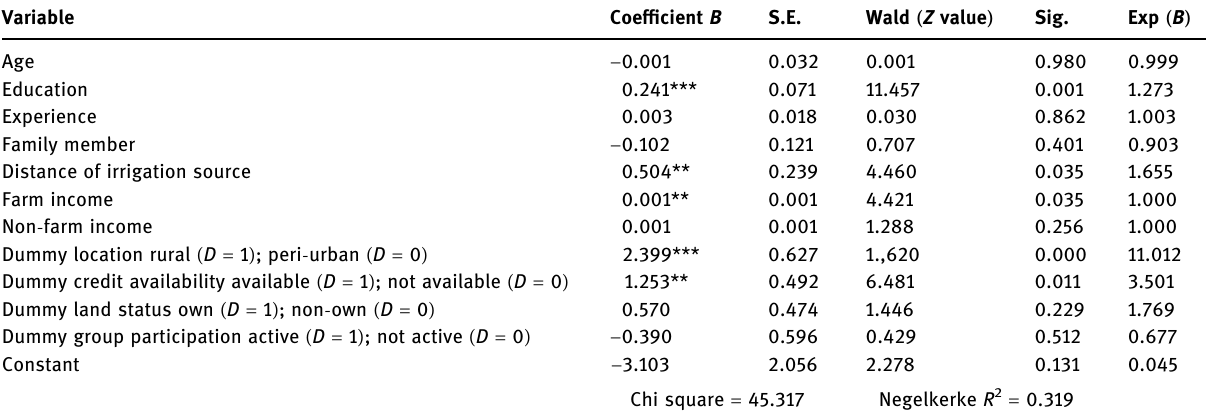
Table 2: Factors a ff ecting farmers ’ willingness to preserve sustainable food agricultural